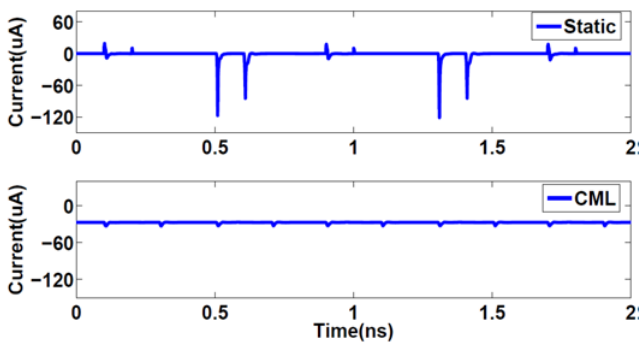
Figure 44. The power traces between TFET static XOR and CML XOR.